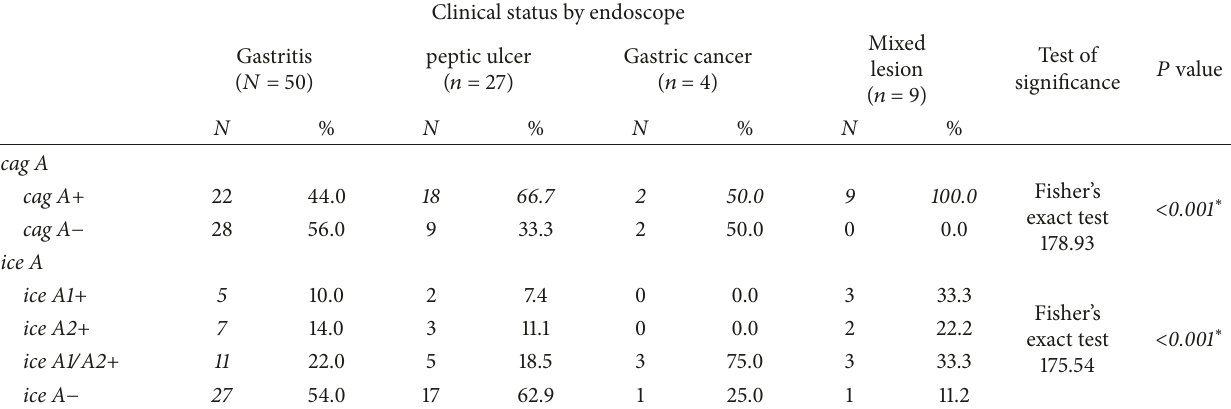
Table 2: Relation between clinical status by endoscope of H. pylori infection and different virulence genes.